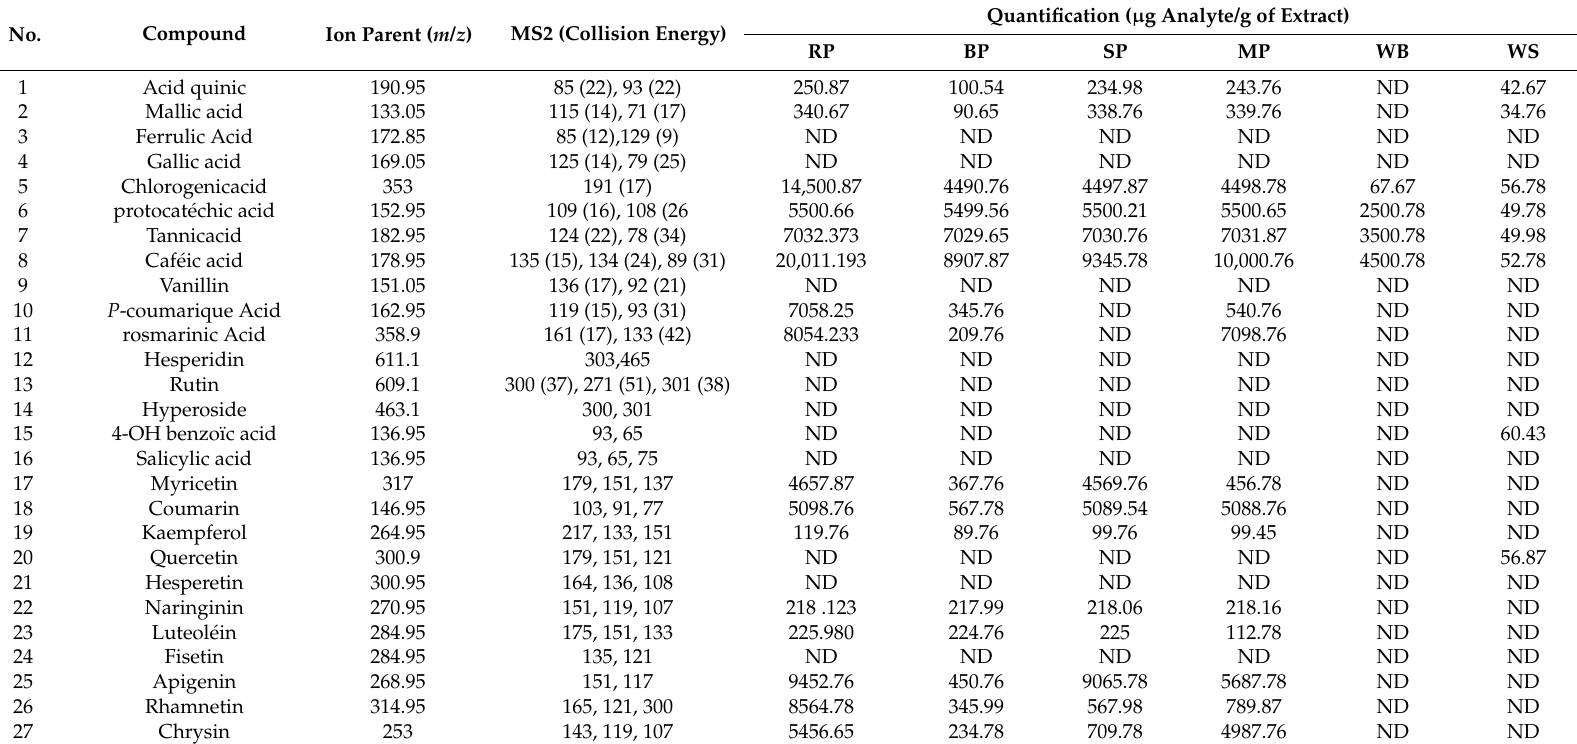
Table 6. Liquid chromatography tandem-mass spectrometry (LC-MS/MS)